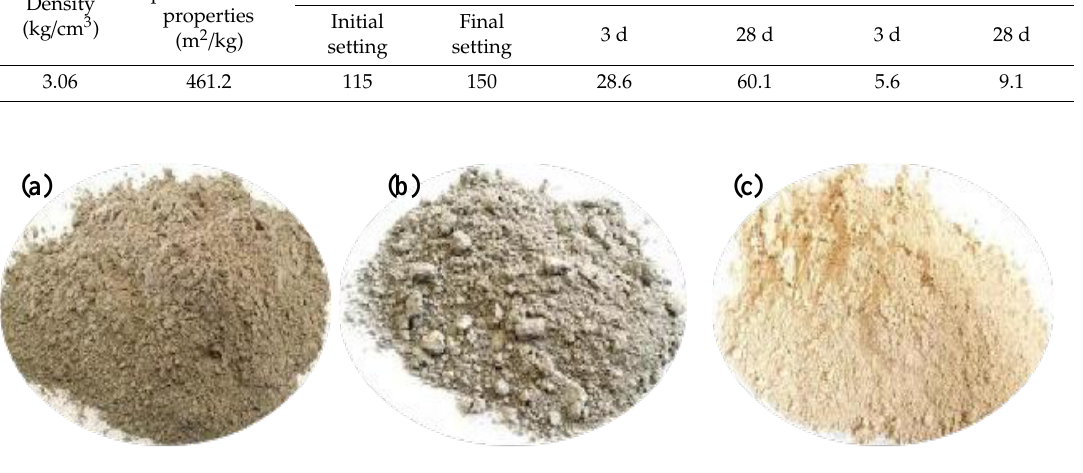
Figure 1. Supplementary cementitious materials (SCMs) used in concrete mixes: ( a ) fly ash (FA), ( b ) ultr-fine fly ash (UFFA) and ( c ) metakaolin (MK).